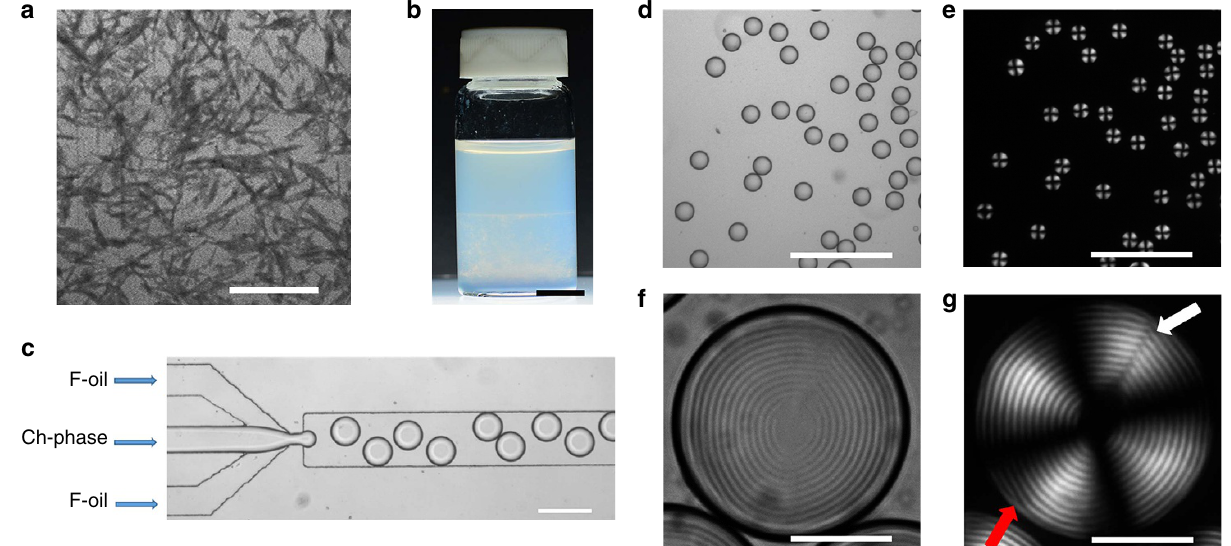
Figure 1 | Generation of droplets by microfluidic emulsification of the Ch–CNC suspension. ( a ) TEM images of dried CNCs. The scale bar is 500nm. ( b ) Phase separation of the macroscopic CNC suspension into a Ch phase (bottom) and an isotropic phase (top). The scale bar is 1cm. ( c ) Optical microscopy image of microfluidic generation of droplets of the Ch–CNC phase. The flow rate of F-oil and the Ch–CNC phase were 0.8 and 0.2mlh (cid:2) 1 , respectively. The scale bar is 250 m m. ( d , f ) Bright-field (BF) optical microscopy images and ( e , g ) corresponding polarized optical microscopy (POM) images of Ch-CNC droplets with f 0 ¼ 0.048. Scale bars are 500 m m ( d , e ) and 50 m m ( f , g ). Arrows in g show the radial disclination line defect running perpendicularly to the Ch layers (white arrow) and an edge dislocation running parallel to the Ch layers (red